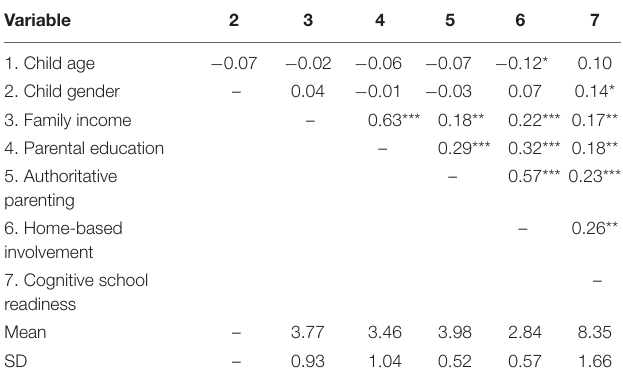
TABLE 1 | Zero-order correlations of main variables.